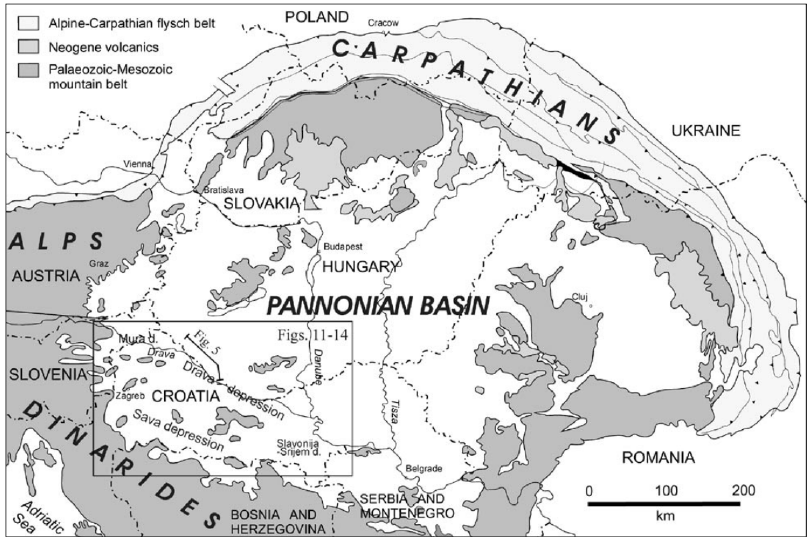
Figure 1. Location of the Croatian part of the Pannonian Basin System within the Pannonian Basin [53].